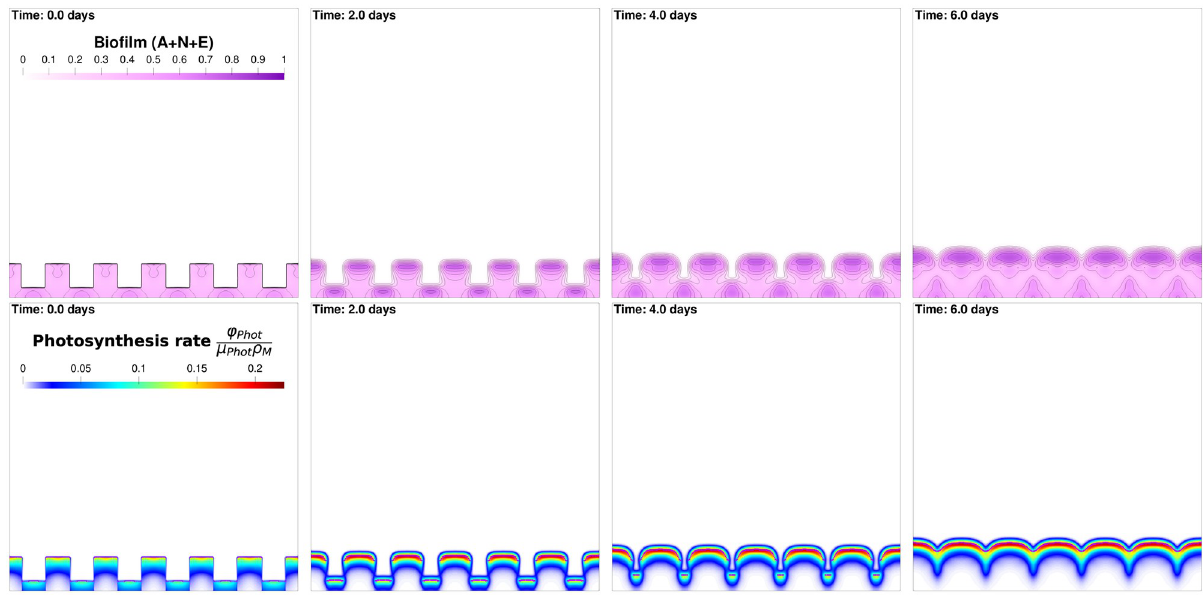
Fig 10. Biofilm (first row) and photosynthesis rate (second row) over an harvesting period. Harvest is performed every 6.5 days, using battlement scraping shape of width 250 μm . The first column, at time t = 0, represents biofilm and photosynthesis rate immediately after the harvest and the last column 6 days after harvest (or equivalently half a day before the second harvest). The columns in between represent the intermediary times t = 2 and t = 4 days after harvest. All these subfigures correspond to square domain of length L x = L z = 3 � 10 − 3 .